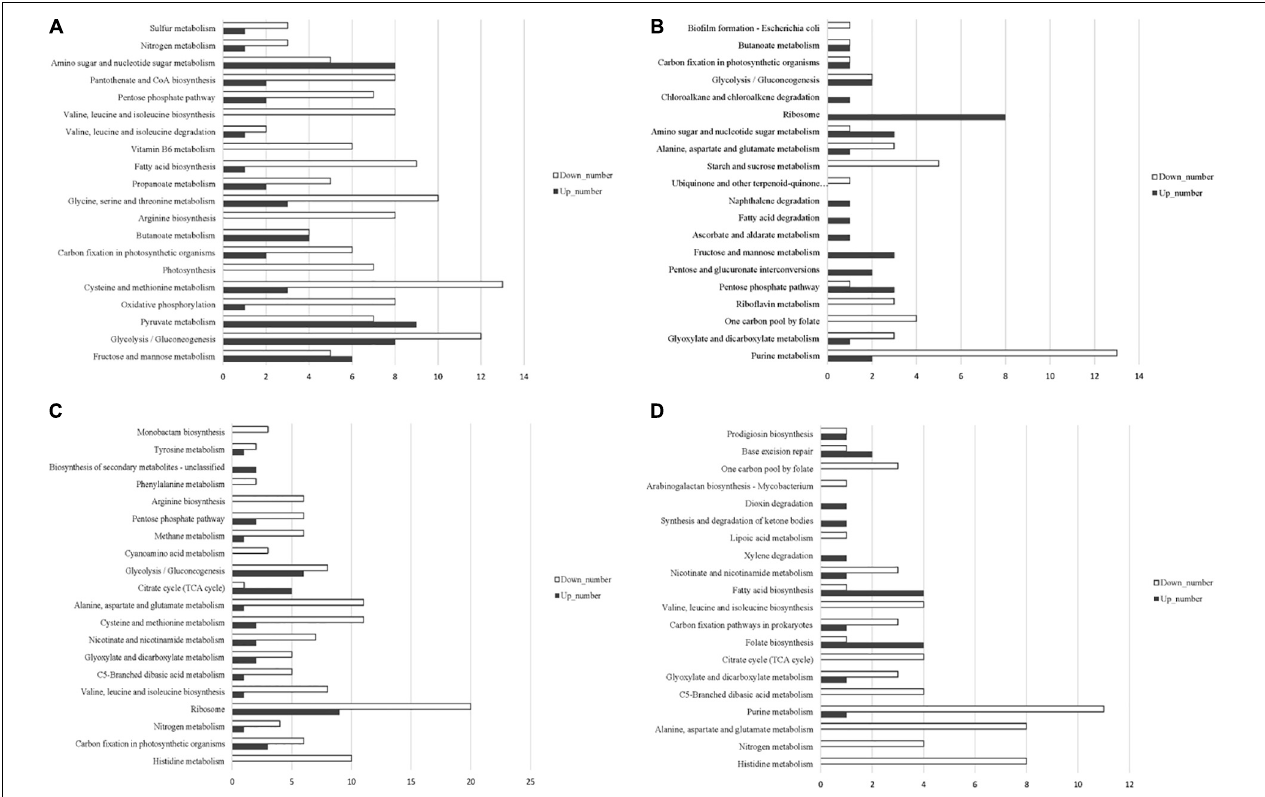
FIGURE 3 | Distribution of upregulated and downregulated genes in the four pair-wise comparisons based on KEGG pathway categories. (A) The comparison between wild-type and its ccpA mutant grown in glucose-excess condition; (B) the comparison between wild-type and its ccpA mutant grown in glucose-limited condition; (C) the comparison between wild-type strain grown in glucose-excess and -limited conditions; (D) the comparison between ccpA mutant grown in glucose-excess and -limited